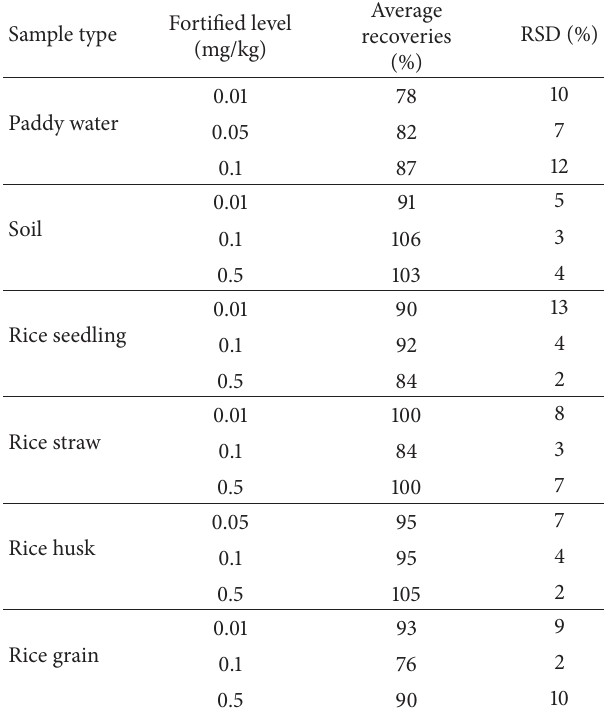
Table 2: Average recoveries and RSDs of thifluzamide in fortified samples ( 𝑛 = 5 ).